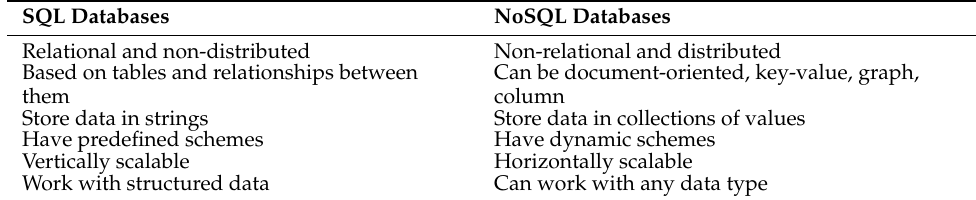
Table 3. Comparison of SQL and NoSQL.